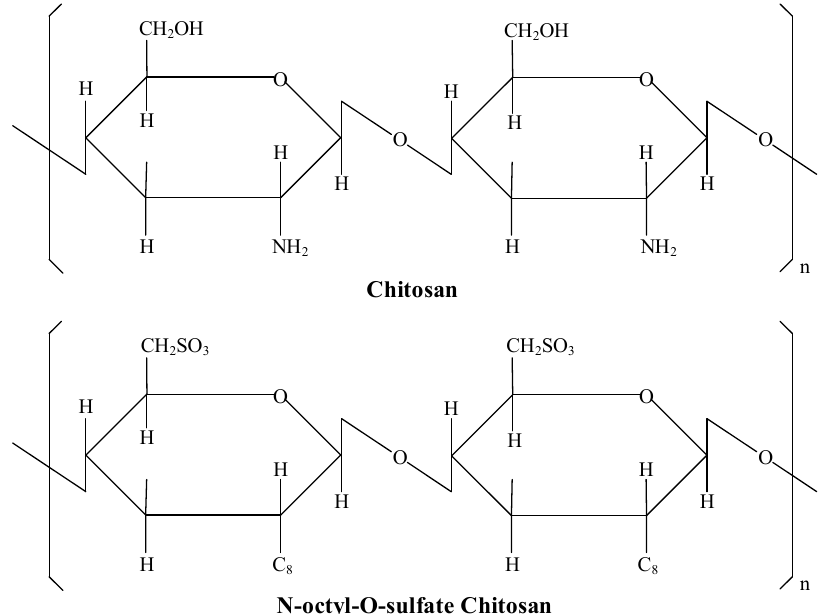
Figure 3. FTIR spectra for the modified chitosan and the modified chitin.